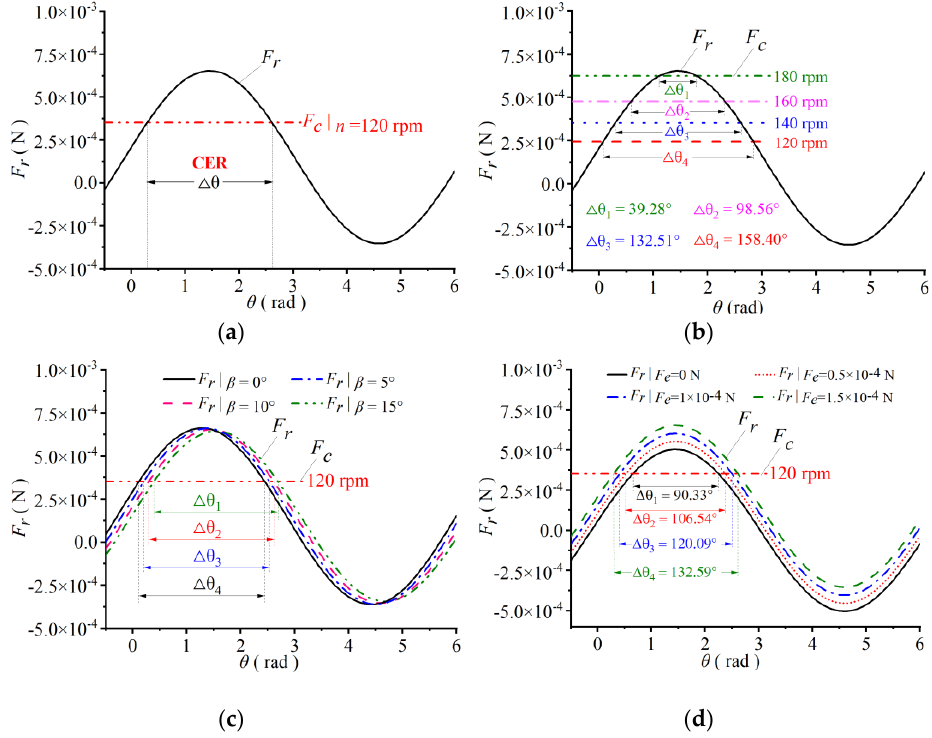
Figure 4. Mechanical analysis diagram. ( a ) F r and F c variations with θ at a rotary speed of 120 rpm, a β value of 10°, and an extrusion force of 1.5 × 10 − 4 N; ( b ) F r and F c variations with θ at a β value of 10°, an extrusion force of 1.5 × 10 − 4 N, and rotary speeds of 120, 140, 160, and 180 rpm; ( c ) F r and F c variations with θ at a rotary speed of 120 rpm, an extrusion force of 1.5 × 10 − 4 N, and β values of 0°, 5°, 10°, and 15°; ( d ) F r and F c variations with θ at a rotary speed of 120 rpm, a β value of 10°, and an extrusion force of 0, 0.5 × 10 − 4 , 1.0 × 10 − 4 , and 1.5 × 10 − 4 N.